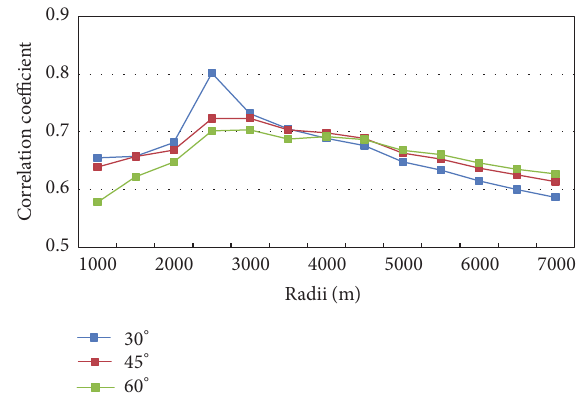
Figure 8: The coefficient of determination between the backscatter- ing coefficient and the ground truth roughness length as a function of upwind sector radius for opening angles of 30 ∘ , 45 ∘ , and 60 ∘